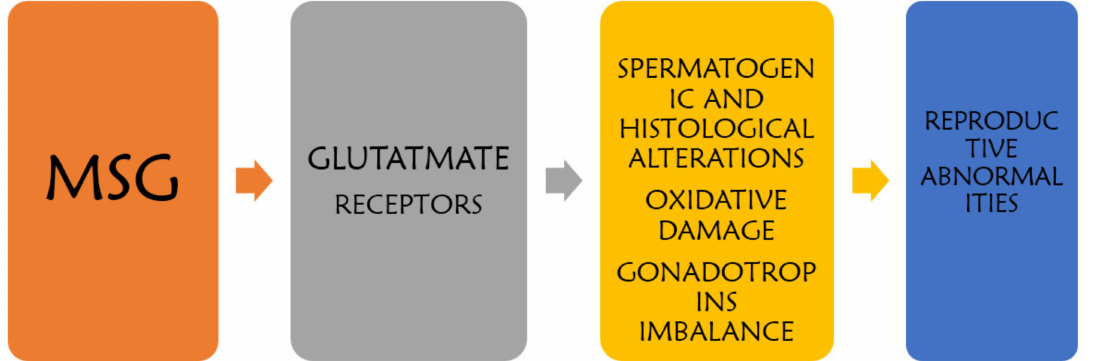
Figure 1. Mechanism of MSG-induced testicular